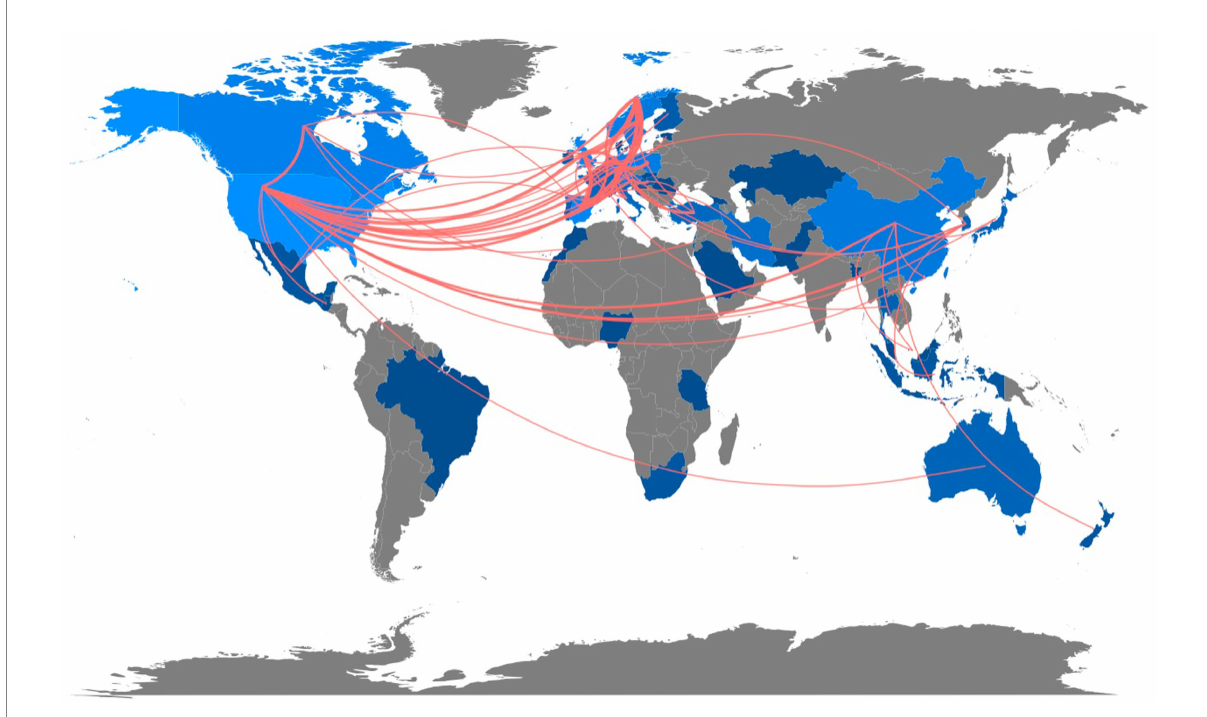
FIGURE 8 Country collaboration map showing research collaboration among countries (at least once) from 1984 to 2022. Note: Blue indicates contribution, and grey indicates no contribution. Different shades indicate collaboration rates: dark blue without extra lines denotes contribution but no collaboration and light blue represents a high contribution level. Redlines show the path of